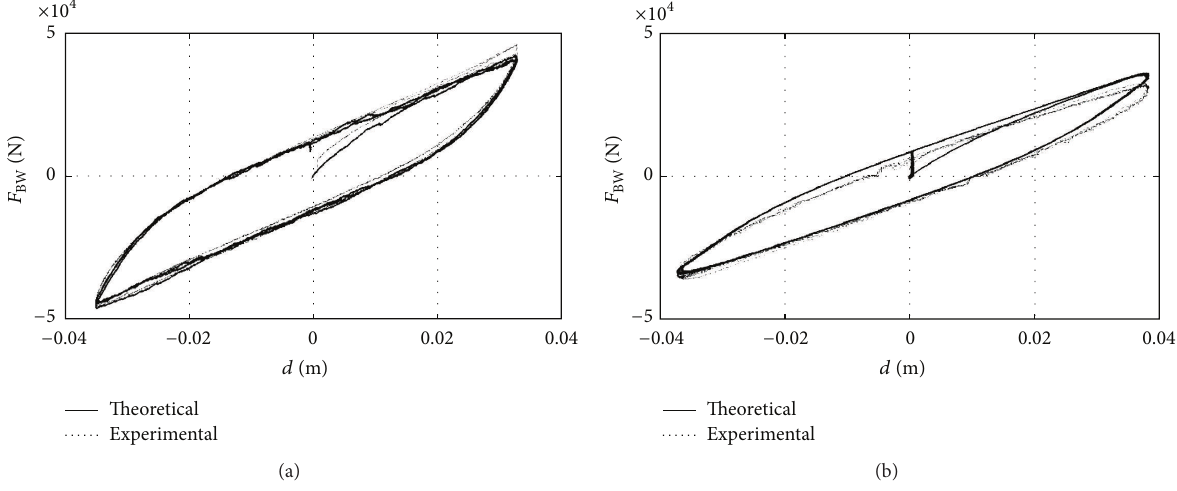
Figure 10: Experimental and simulated hysteretic cycles: (a) IUT a; (b) IUT b [12].